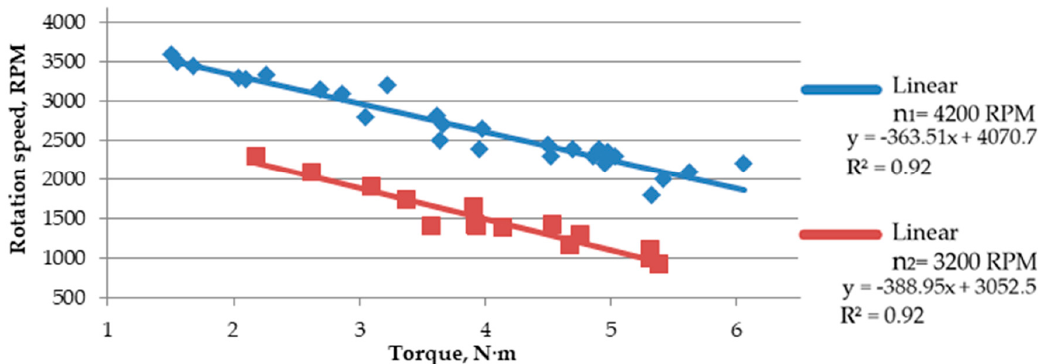
Figure 10. The dependence of the rotation speed vs. torque for Rosa multiflora .